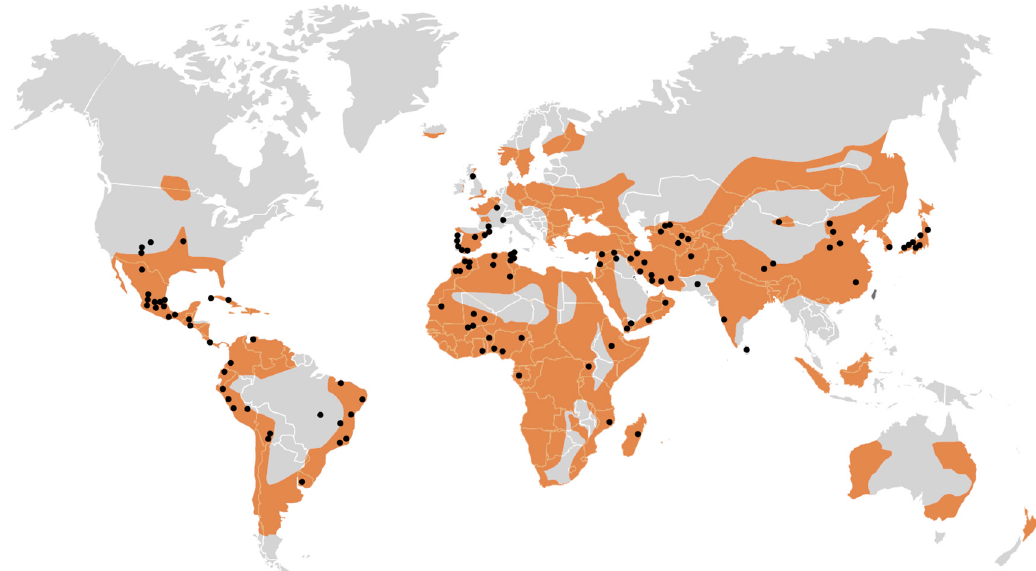
Figure 1. Areas of occurrence of numerous buildings made of earth (yellow color). The black points marked the earth architecture inscribed in the UNESCO World Heritage List [2].